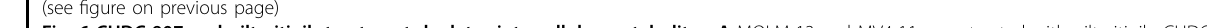
Fig. 6 CUDC-907 and gilteritinib treatment depletes intracellular metabolites. A MOLM-13 and MV4-11 were treated with gilteritinib, CUDC- 907, both, or vehicle control for 4 or 8 h. Western blots were generated utilizing whole-cell lysates, with representative blots shown, and densitometry displayed below each blot. Densitometry was assessed via comparison to vehicle control and normalized to β -actin. B MV4-11 cells were treated with gilteritinib and/or CUDC-907 for 8 h, at concentrations of 12.5 nM. Cells were collected, washed with PBS, and cell pellets were stored at − 80 °C. Metabolites were quantitatively pro fi led using LC-MS/MS-based targeted metabolomics platform in the Karmanos Cancer Institute Pharmacology Core. Data were analyzed using www.MetaboAnalyst.ca, version 4.0. Heatmap analysis of the 125 metabolites with signi fi cantly different expression levels is shown. C Pathway analysis of the 125 metabolites with signi fi cantly different expression levels is shown. D MOLM-13 and MV4-11 cells were treated with vehicle control, gilteritinib, CUDC-907, or in combination for 8 h, and then the cells were washed and resuspended in fresh media without gilteritinib or CUDC-907. The cells were counted daily with trypan blue staining. Total number of cells are graphed in the left panels, while the percentage of dead cells (trypan blue positive cells) is graphed in the right panels. * p < 0.05, ** p < 0.01, *** p < 0.001, and ns indicates not signi fi cant (left panels: compared to vehicle control and gilteritinib treatment; right panels: compared to vehicle control and single-drug